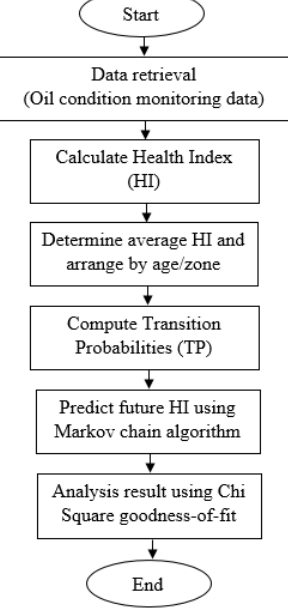
Figure 2 . Modeling process of deterioration performance curve based on the Markov Model (MM). Figure 2. Modeling process of deterioration performance curve based on the Markov Model